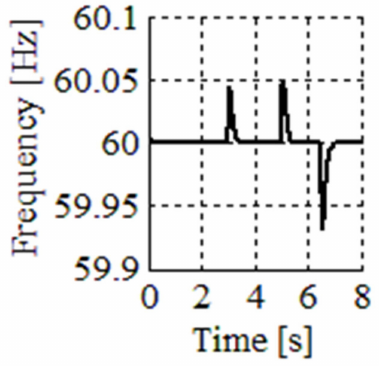
Figure 11. Frequency signal of the regulation loop with three single-phase